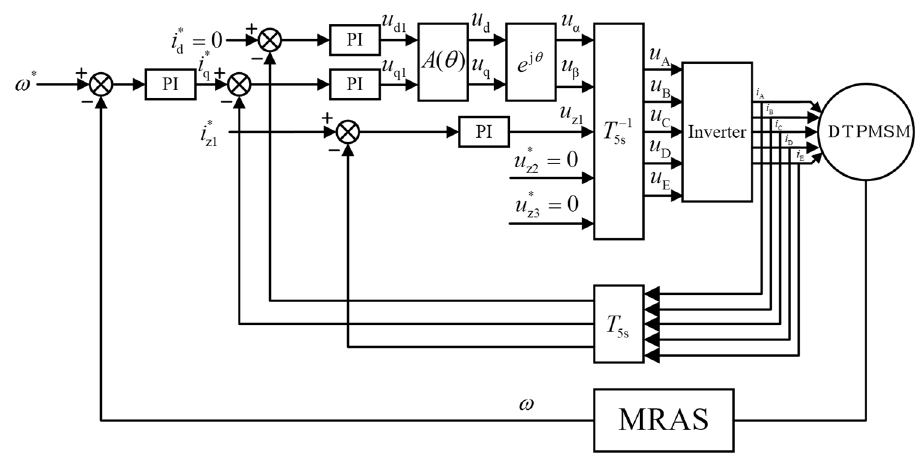
Figure 3. Block diagram of the fault-tolerant control strategy.